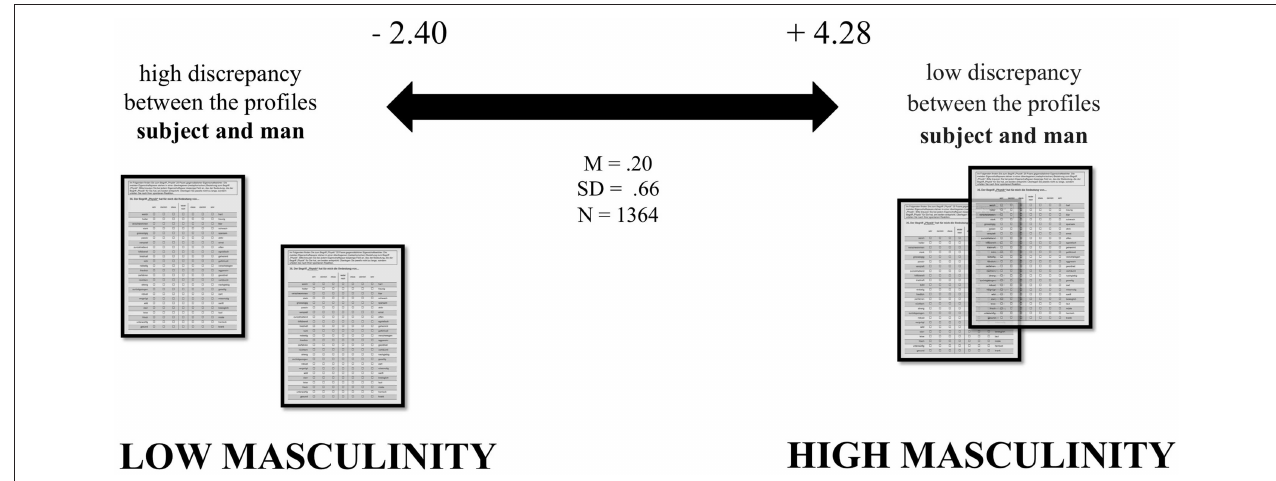
FIGURE 1 | Masculinity index of chemistry, math, and